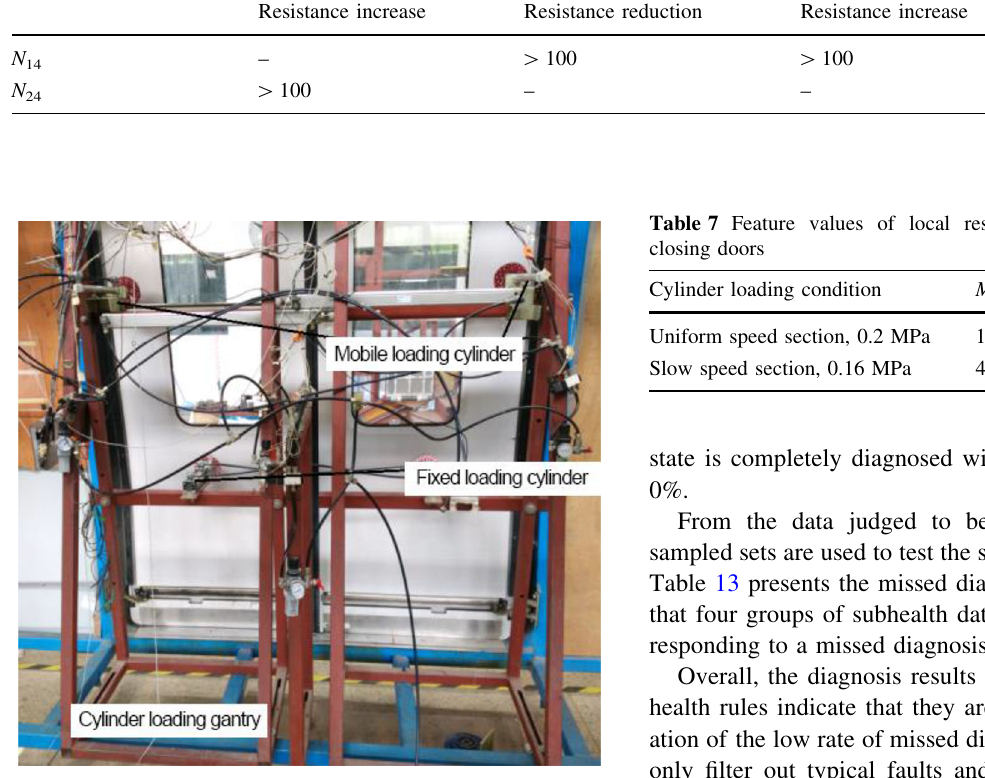
Fig. 10 Cylinder loading